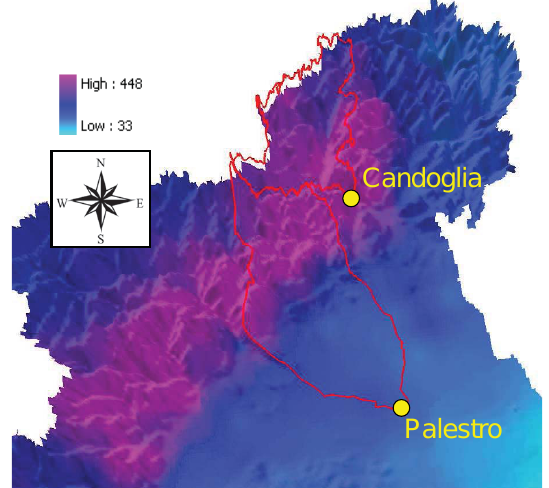
Fig. 2. 3-D map of the precipitation cumulated [in mm] between 1 and 5 November 2008 over the Toce and Sesia basins; colours show the quantitative observed precipitation. The digital elevation model of the terrain is shown in 3-D.